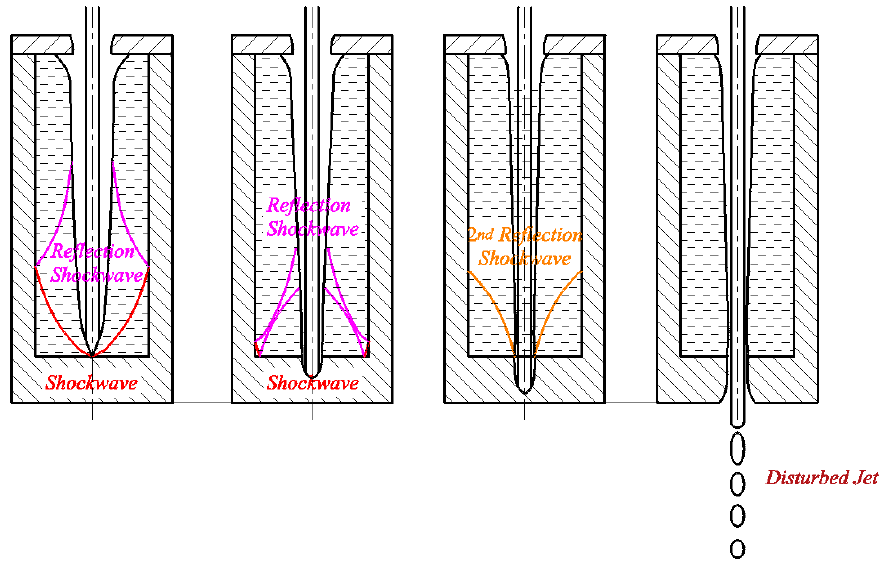
Figure 4. Formation and propagation of the bottom plate reflection shock wave. The fifth stage is liquid spraying and side-wall secondary reflection interference.